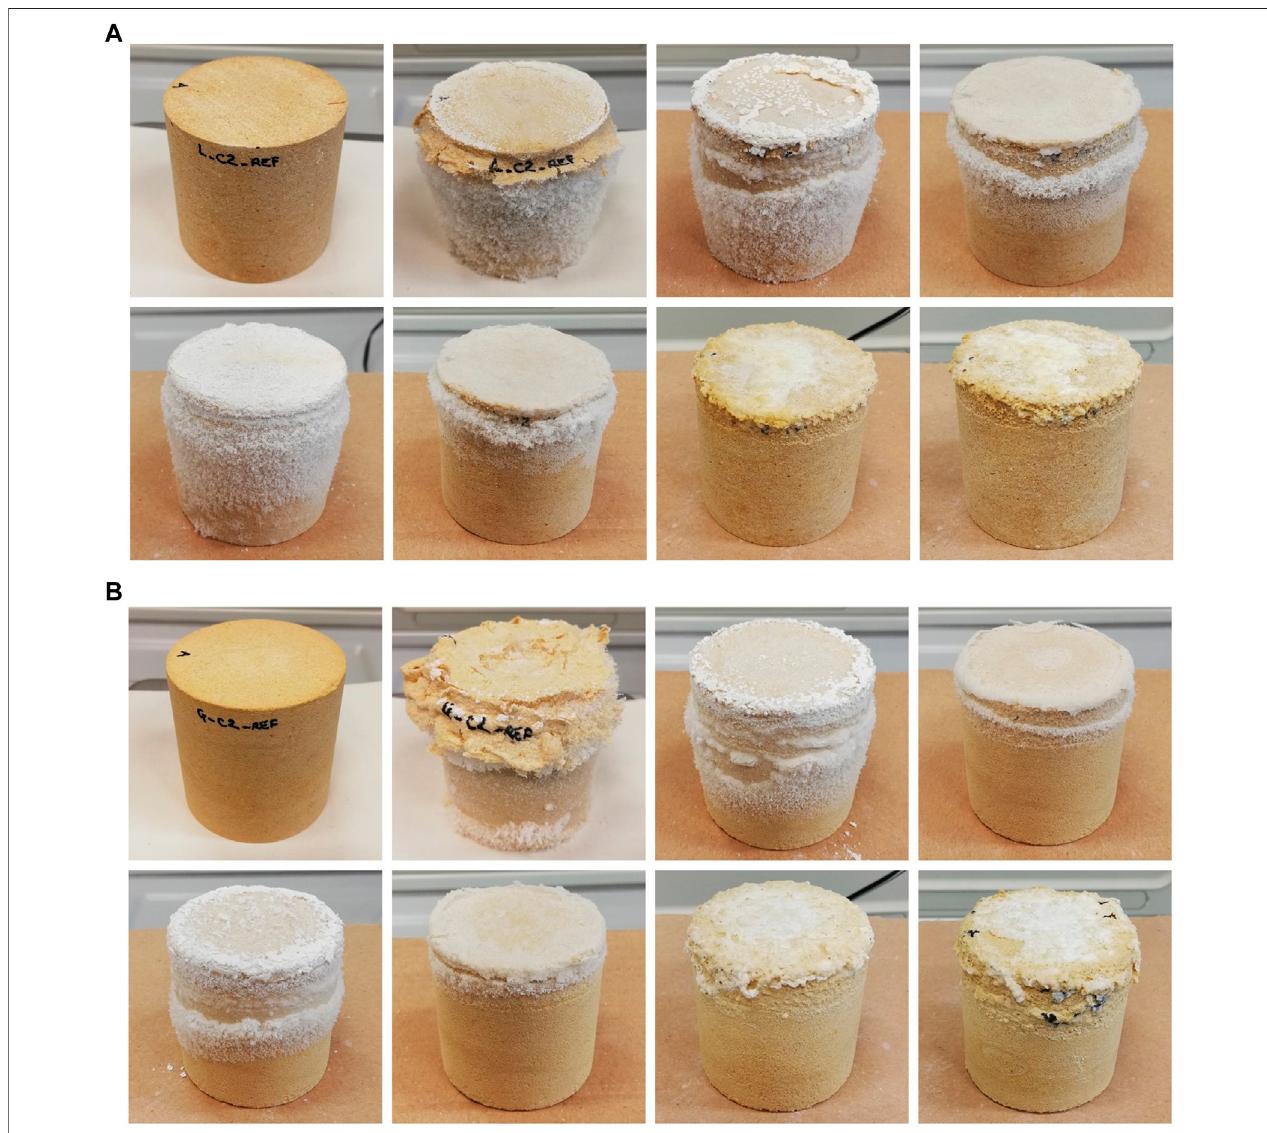
FIGURE3| Signi fi cantUTcylinders at the1st,2nd,4th, 6th,10th, 12th,16thand 20thcycles ofthesalt crystallization test for: (A) Lecce stoneand (B) Globigerina limestone. The photos were taken after the drying phase, before brushing.